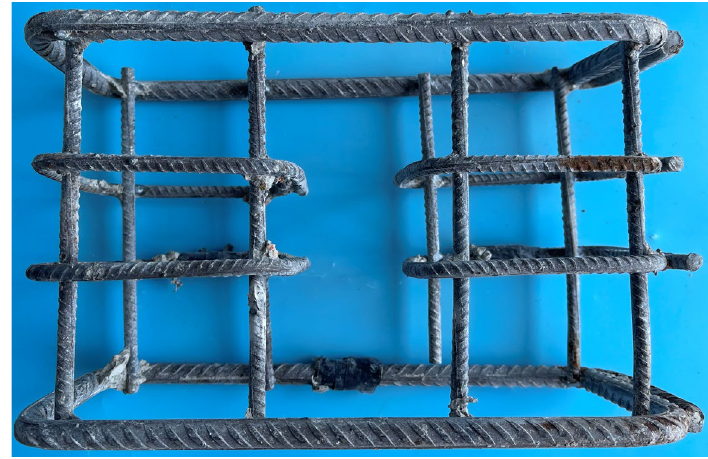
14 of 31 Figure 15. Strain development of stirrup ( a ) M4-D12-7.5d-1; ( b ) M4-D12-7.5d-2; ( c ) M4-D12-7.5d-3. The confined stirrup can strengthen the core concrete, which can improve the bearing capacity of CHBC. In addition, the confined stirrups are across the diagonal crack region.